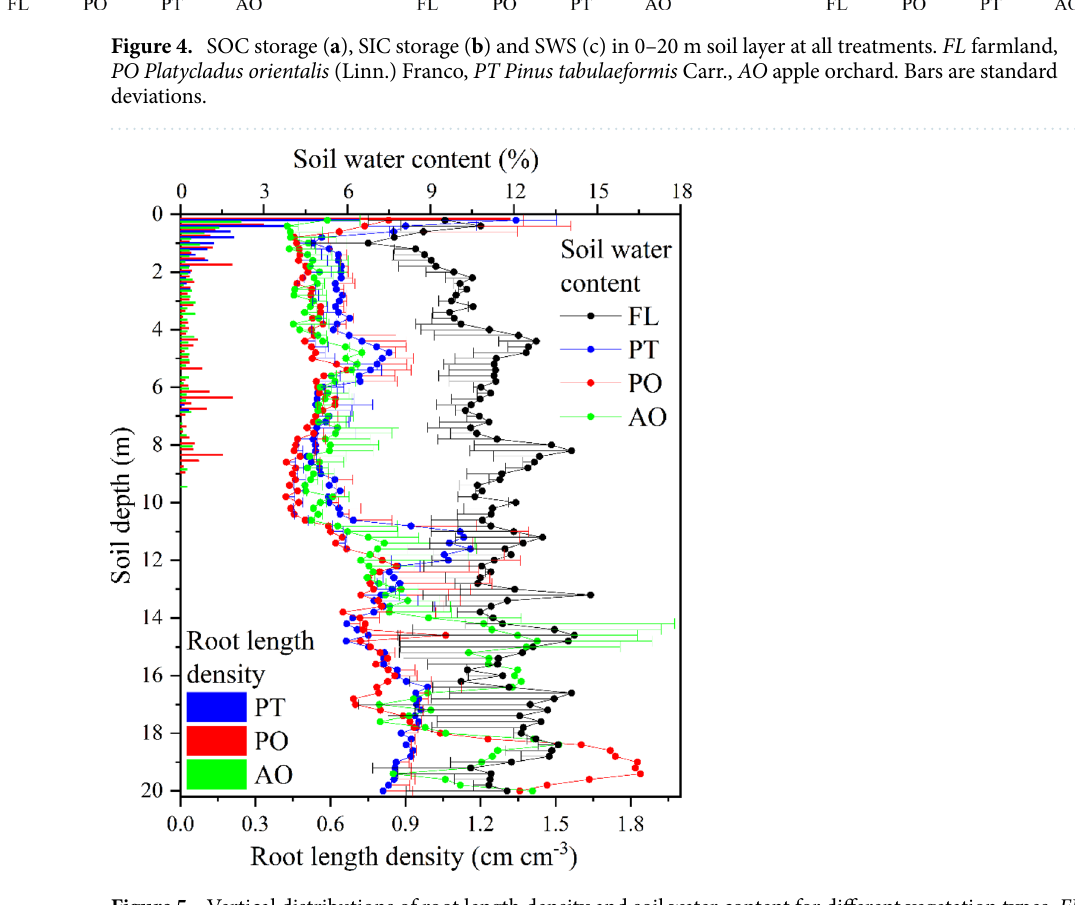
Figure 5. Vertical distributions of root length density and soil water content for different vegetation types. FL farmland, PO Platycladus orientalis (Linn.) Franco, PT Pinus tabulaeformis Carr., AO apple orchard. Bars are standard